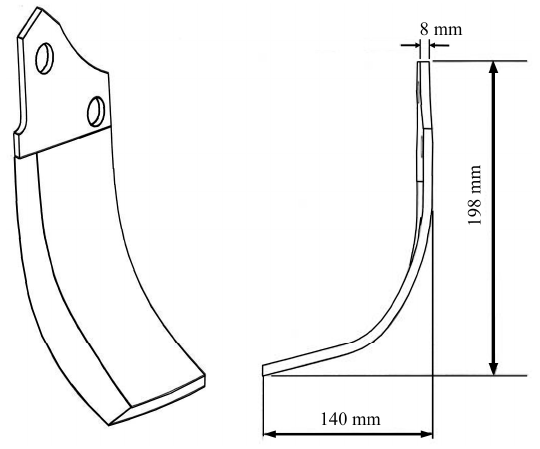
Figure 3. Prototype of the developed inter-row cultivator: ( a ) power take-off (PTO) shaft; ( b ) gear box; ( c ) rotor; ( d ) chain box; ( e ) blade; and ( f ) notch-cutting disc.